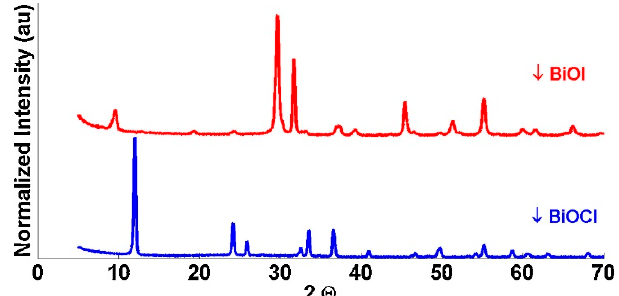
Figure 5. XRD spectra for BiOI and BiOCl. Reused with permission from reference [12]. Copyright Elsevier 2015.